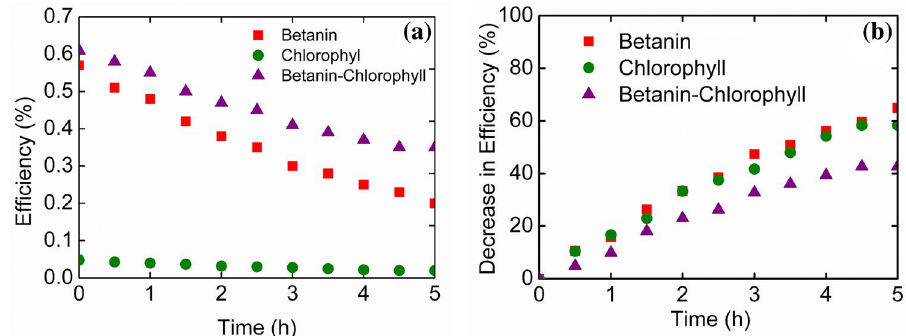
Fig. 7 Change in the efficiency of the three configurations of solar cells under 5 h of constant illumination: a absolute effi- ciency decrease. b Normalized efficiency